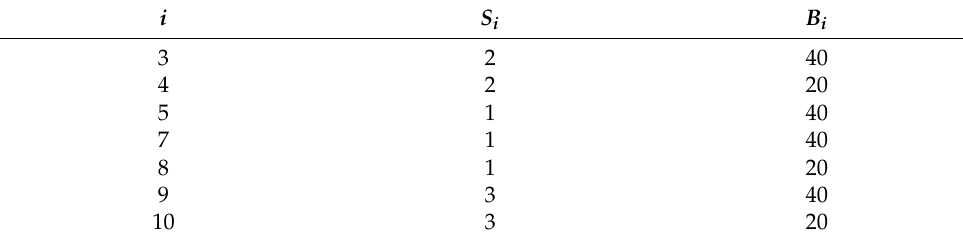
Table 3. Node Configurations for Sum-rate Maximization.